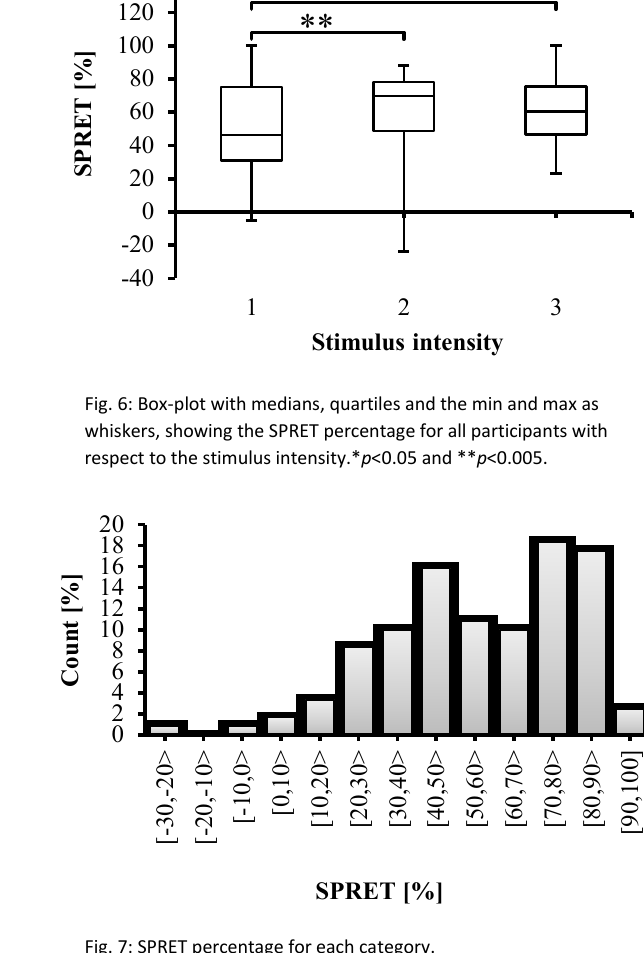
Table 2 : Statistical analysis with a linear mixed effects model. Parameters